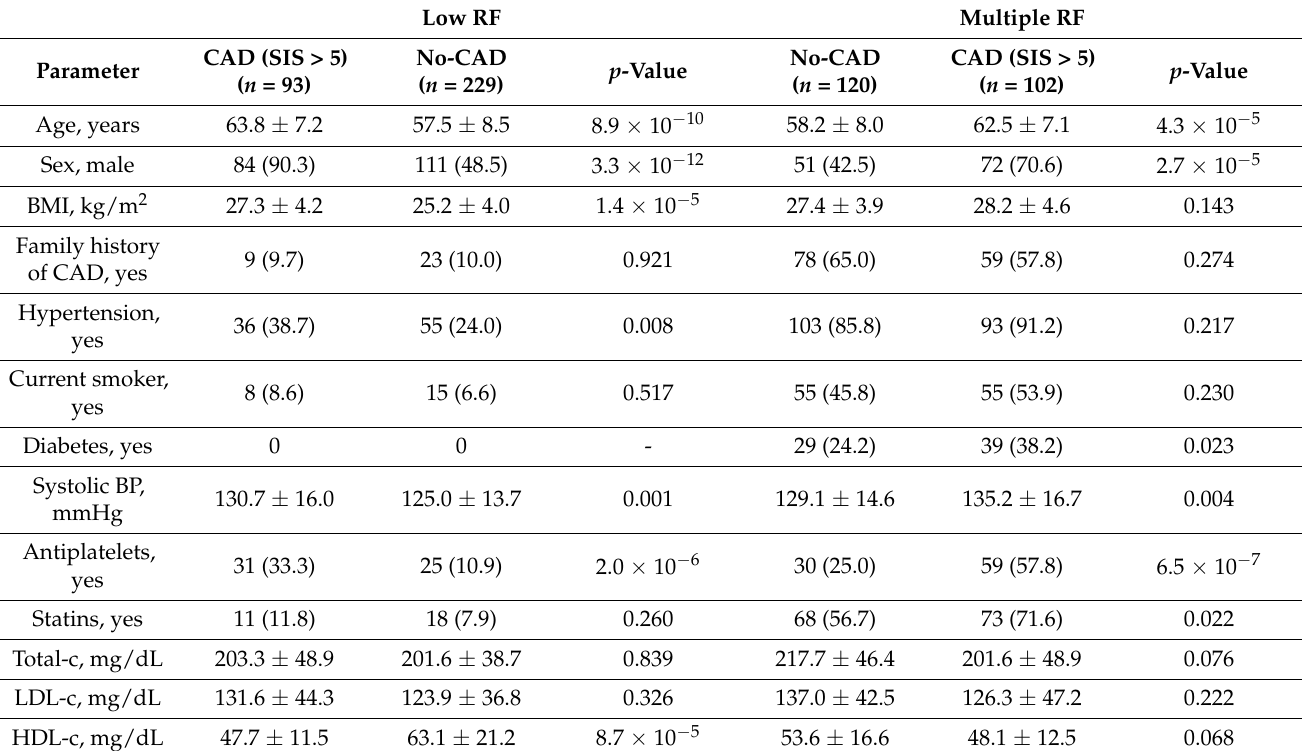
Table 1. Characteristics of the study cohort stratified by the burden of risk factor (RFs) and the presence of coronary artery disease